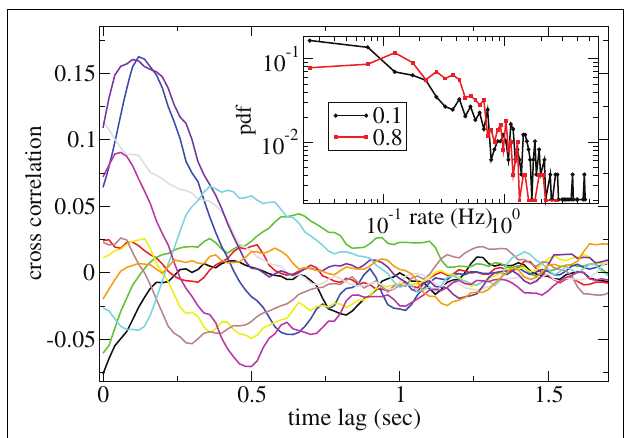
FIGURE 3 |Time-lagged cross-correlations for some randomly chosen cell pairs from a 500 cell network simulation based on a 40-ms sliding window, connectivity 0.1, same parameters as Figure 1. (Inset) Distributions of cell firing rates for two network simulations, connectivity 0.1 (black) and 0.8 (red), same parameters as Figure 1 .